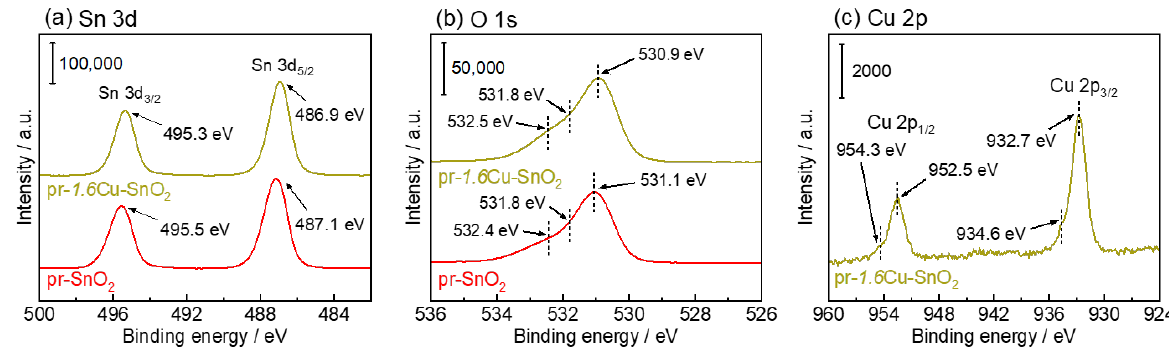
Figure 6. ( a ) Sn 3d, ( b ) O 1s, and ( c ) Cu 2p XPS spectra of as-prepared pr-SnO 2 and pr- 1.6 Cu-SnO 2 powders.